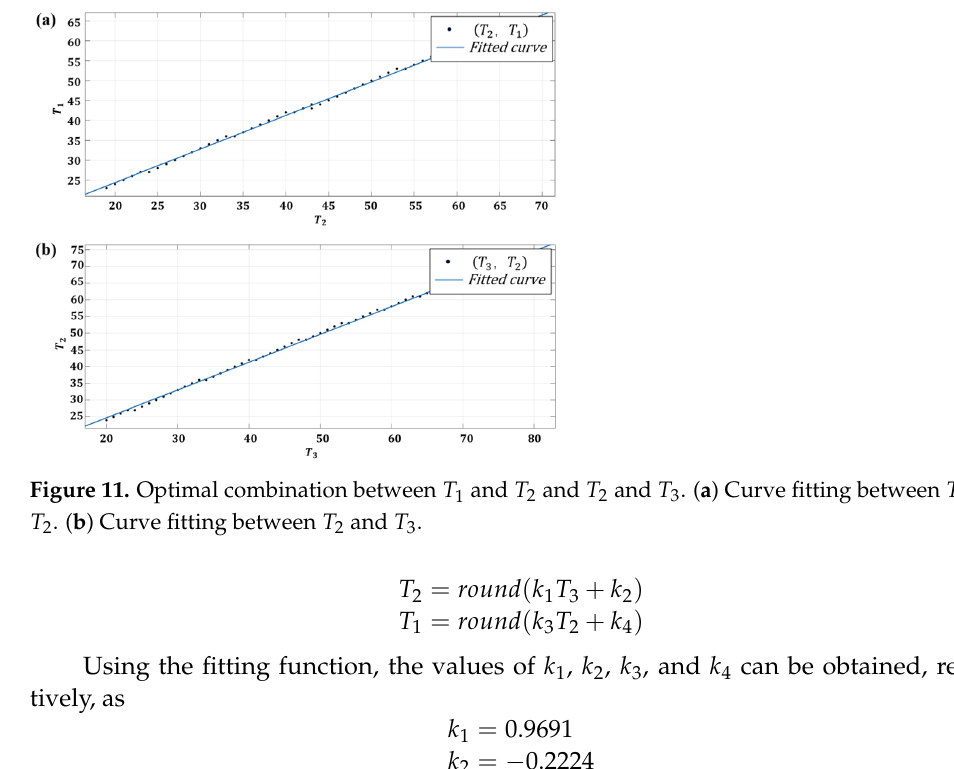
T and T and T and T . ( a ) Curve fitting between 1 2 2 3 T and T . 2 3